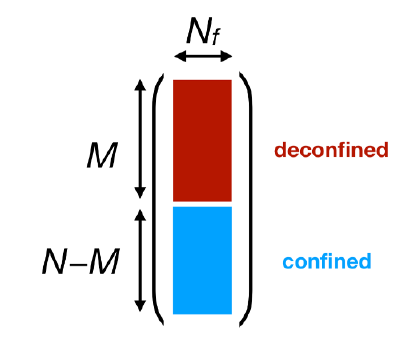
Figure 3 . Partial decon(cid:12)nement in the vector